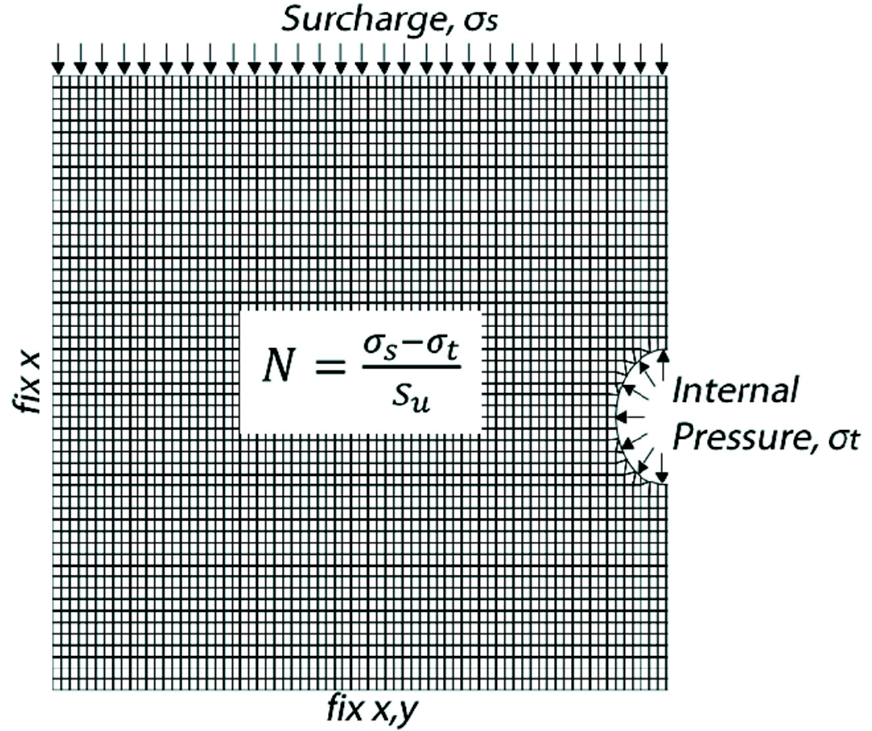
Figure 4. Typical mesh of the problem.